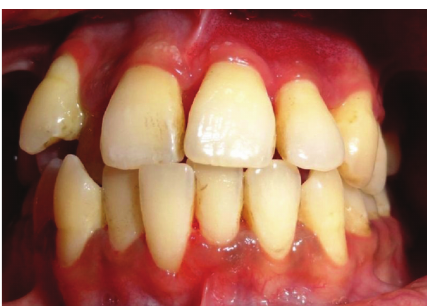
Figure 4: 3 months postoperative